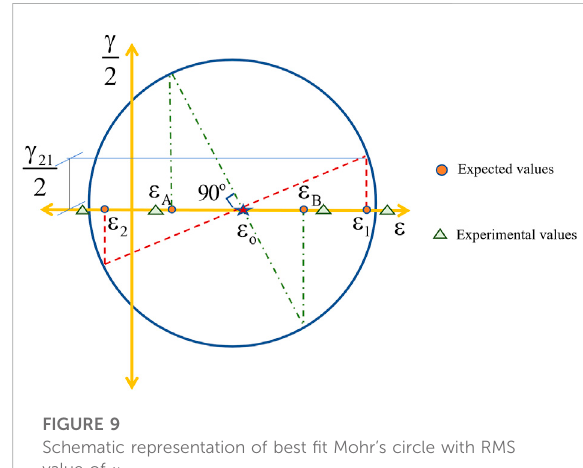
FIGURE 9 Schematic representation of best fi t Mohr ’ s circle with RMS value of γ